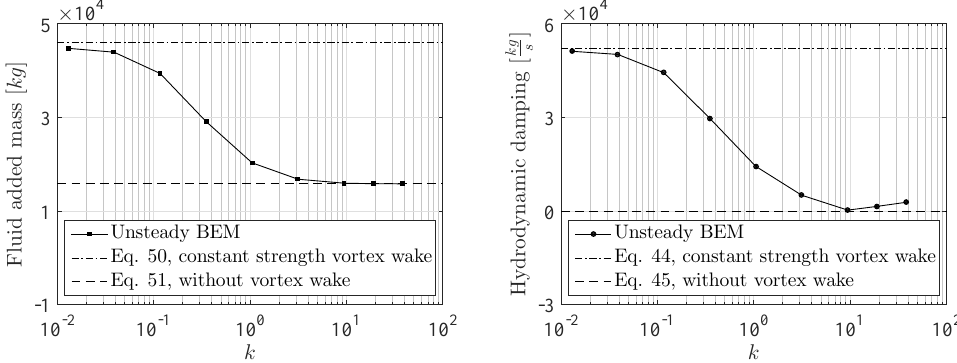
Figure 6. Added mass and hydrodynamic damping of the hydrofoil for different plunge